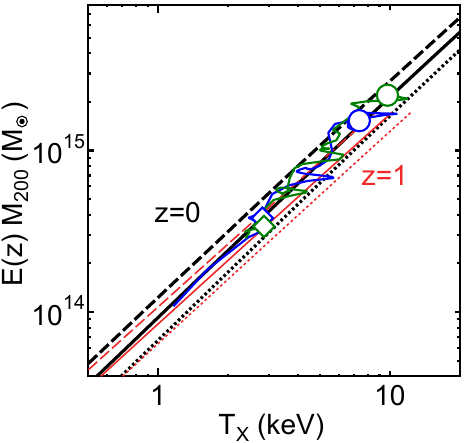
Figure 7. The same as Figure 6 but for ∆ = 200 and n = − 2. Blue and green curves present the evolutions of two of the clusters shown in Figure 4. Circles and diamonds show the points of z = 0 and 1,